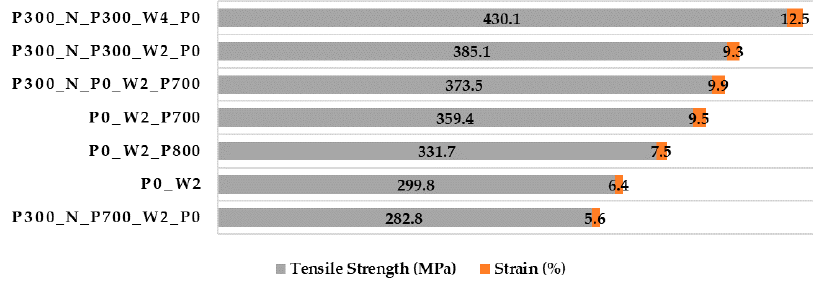
Figure 16. Graphical representation of tensile test results.